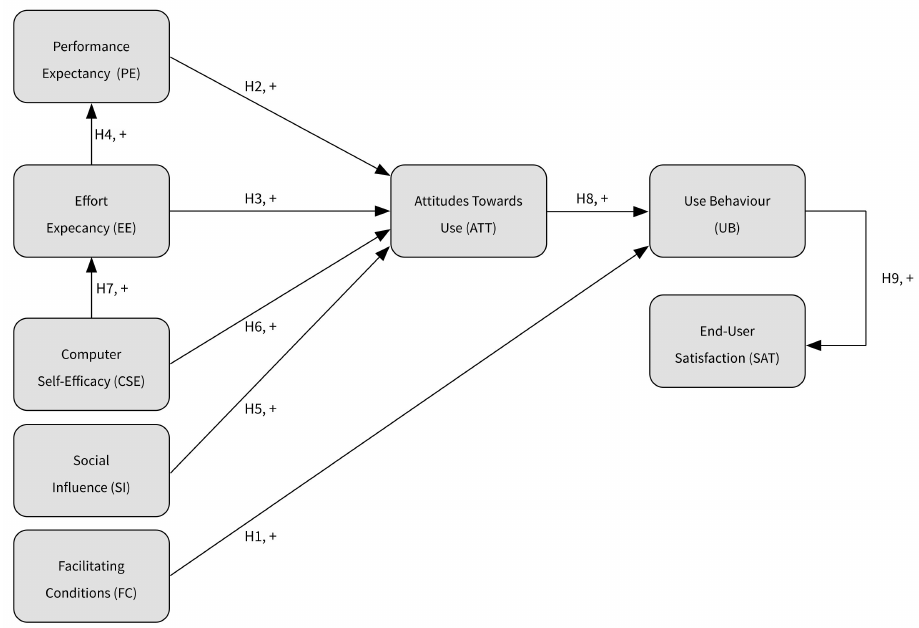
Figure 1. The constructed research model based on the unified theory of acceptance and use of technology (UTAUT). + positive relationship.